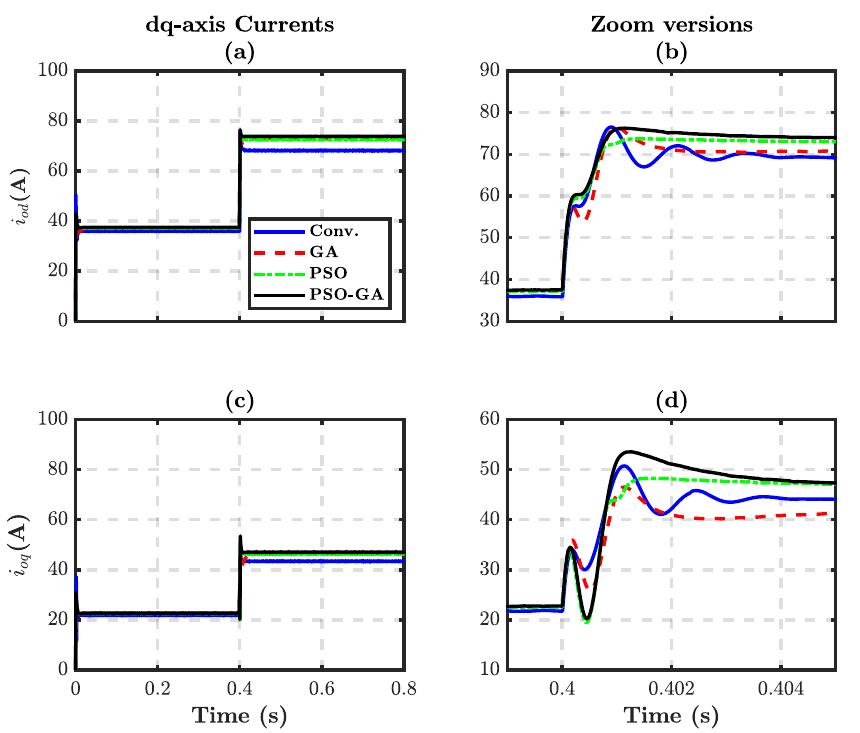
Figure 14. Islanded MG response under linear load changes showing the evolution of frequency.